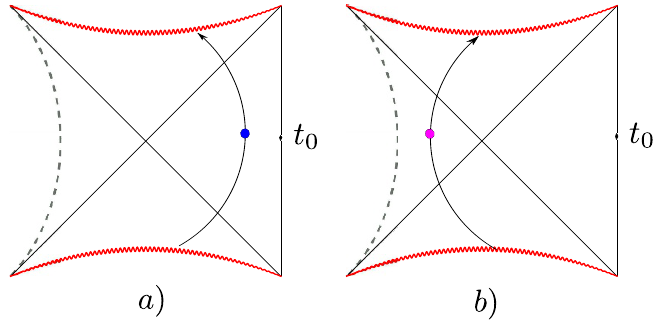
Figure 6 . Autonomous non-equilibrium states of the form: a) U ( O ( t 0 )) j (cid:9) 0 i and b) U ( e O ( t 0 )) j (cid:9) 0 i . could be something of the form e ig O ( t 0 ) , appropriately smeared. For t (cid:28) t like an equilibrium state. At around t = t past horizon, coming from the white hole region, reaches a maximum distance in AdS and falls back into the future horizon. The di(cid:11)erence of energy between j (cid:9) i and j (cid:9)